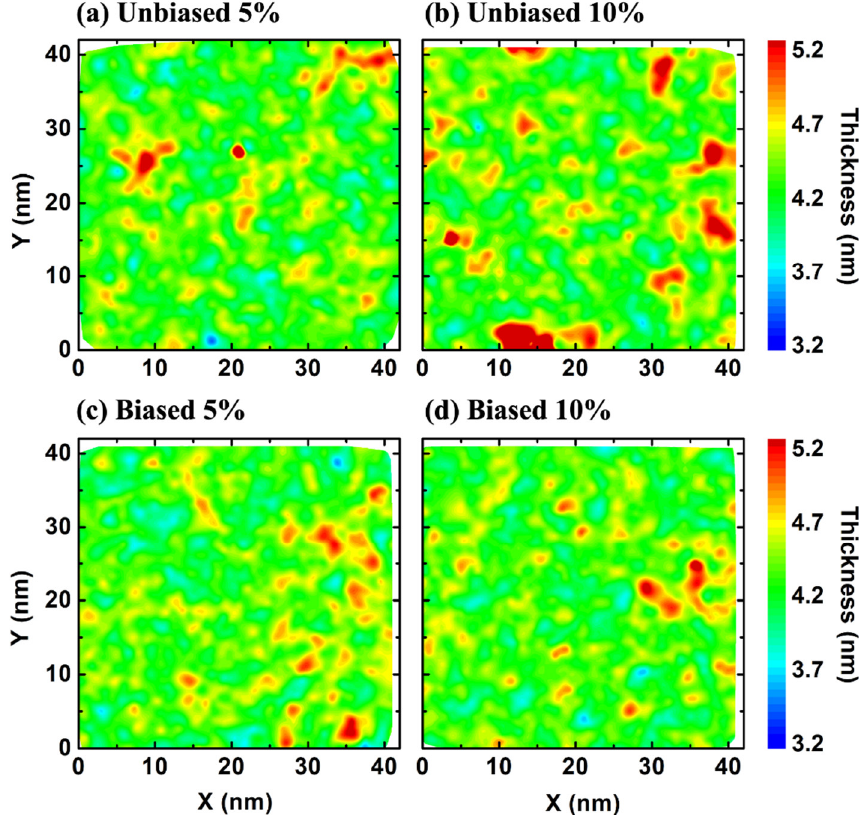
Figure 6. Bilayer thickness at ( a ) unbiased 5%, ( b ) unbiased 10%, ( c ) biased 5% and ( d ) biased 10% fullerene concentrations. Increase in plasma membrane thickness is correlated with the locations of fullerene aggregation. The titles in each of the figures show the fullerene concentration and if the simulation was biased or unbiased.